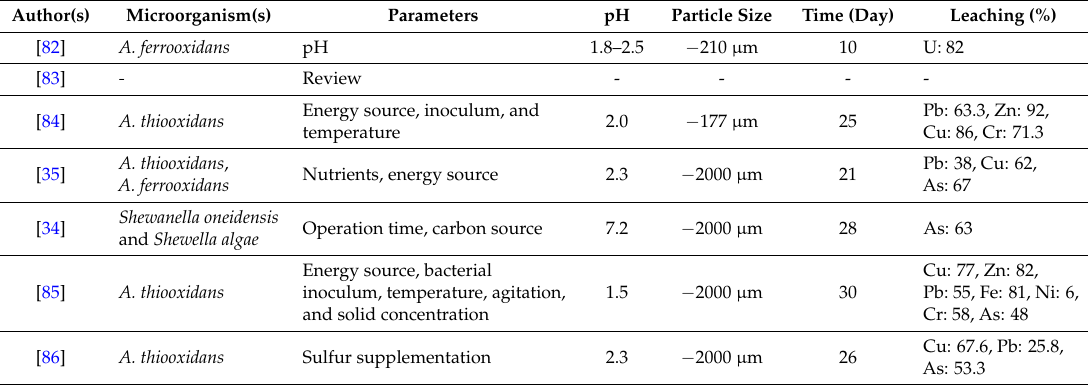
Table 6. Bioleaching research of contaminated soils research according to the parameters studied and recoveries achieved as well as microorganisms used in the studies. The articles appear in chronological